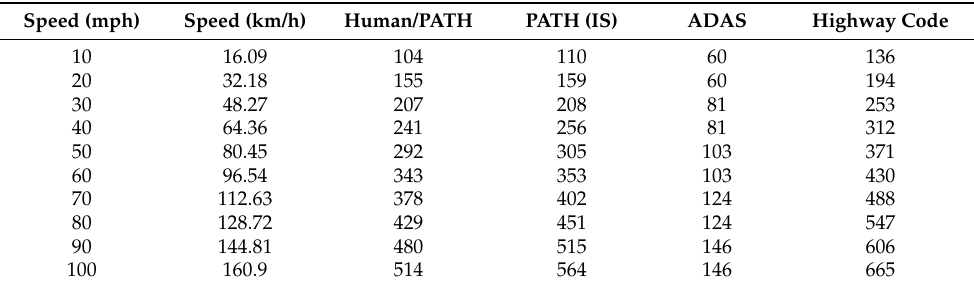
Table 7. Losses per 1000 packets.